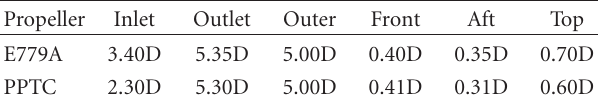
Table 2: Distances of the boundaries/surfaces from the propeller mid plane in axial direction for inlet, outlet, front, aft, and from the propeller rotation axis centreline in radial direction for outer and